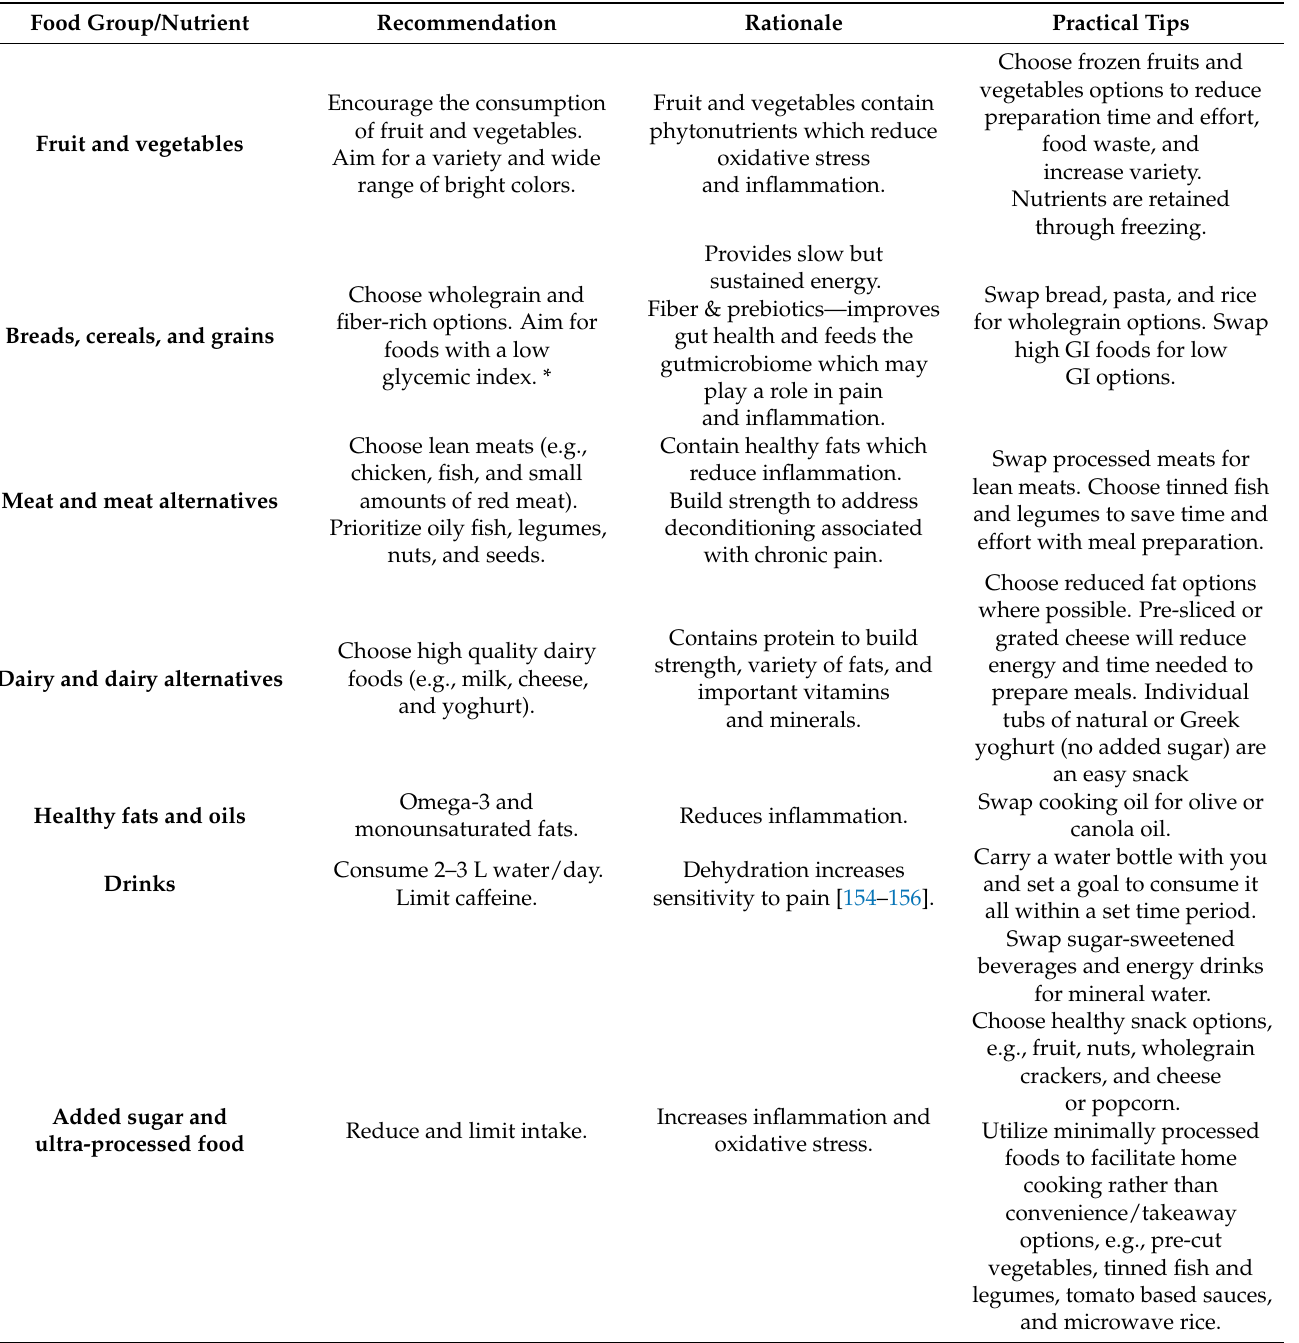
Table 2. Nutrition recommendations for people experiencing chronic